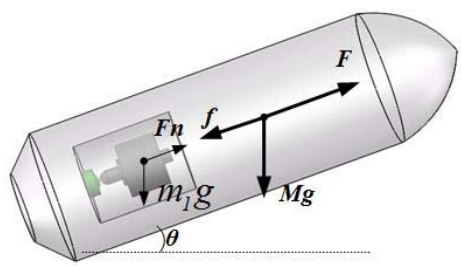
Figure 10. Force analysis of inertial free flight phase.